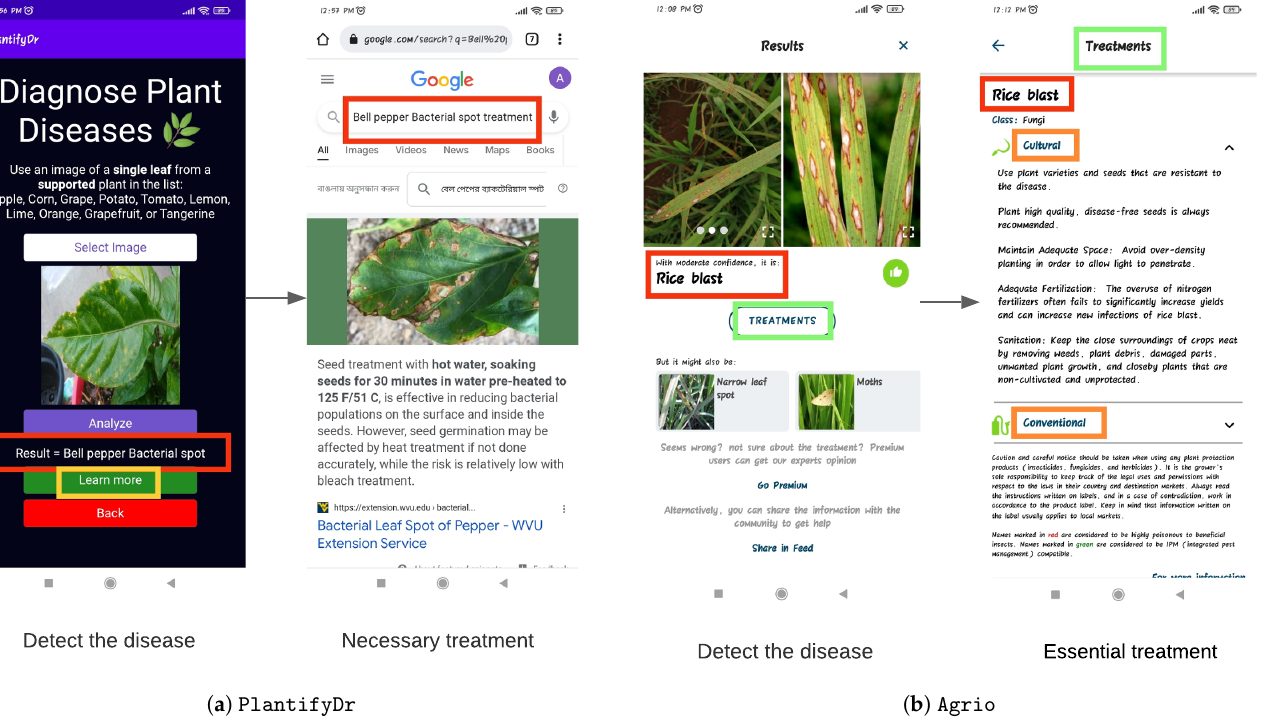
Figure 7. Treatment. Figure 7. Apps screenshots of treatment